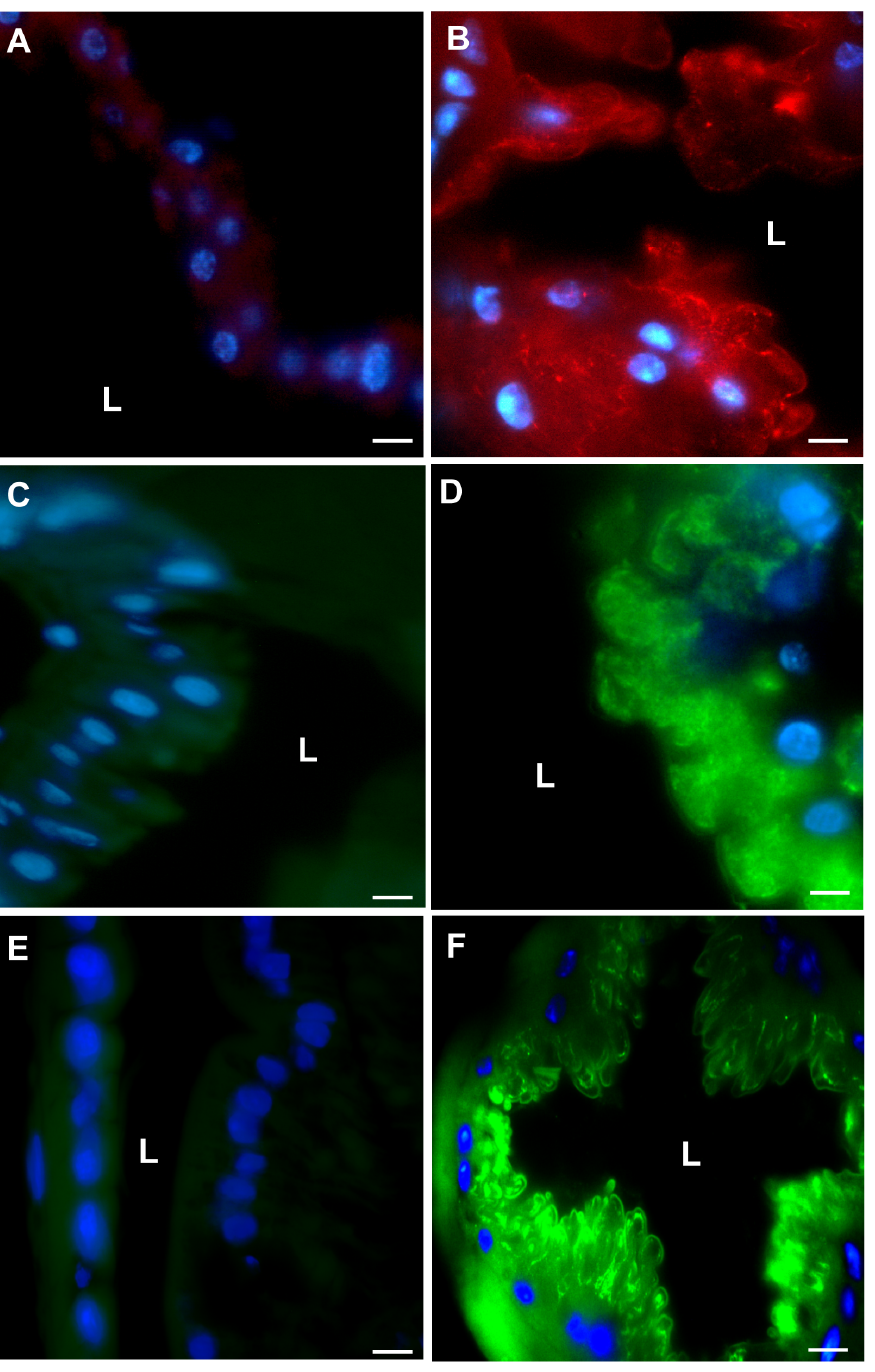
Figure 5. Temporospatial antimicrobial peptide detection in the alimentary canal of house flies fed GFP- P.aeruginosa . Flies (n=12 in each of three replicates) were fed an average of 1.05 6 10 5 CFU (SD=3.37 6 10 4 ) bacteria, and at 4, 6, and 8 h post-ingestion flies (n=4 per replicate) were dissected to remove the alimentary canal. Control flies (n=4) were fed sterile BHI broth and dissected at 2 h PI. Immunofluorescent microscopy was used to detect the antimicrobial peptides (AMPs) Cecropin (A, B), Defensin (C, D) and Diptericin (E,F). AMPs were detected in the midgut in flies fed bacteria at 6 h PI (B, D, F) by immunofluorescent microscopy, but not in control flies (A, C, E). AMPs also were detected in the midgut at 8 h PI, and in other tissues (not shown, discussed in the text). L, gut lumen. Scale bar=10 m m. intriguing to measure the long term fluctuations and feedback Additionally, the underlying feedback mechanisms between fly between bacteria population counts and AMP protein-level immune responses and bacteria population densities still remain expression. Other AMPs and antimicrobial effectors likely play a unknown, and we know very little about gut-microbe interactions role in house fly-microbe dynamics and warrant further study. in higher diptera except for the model organism D. melanogaster.